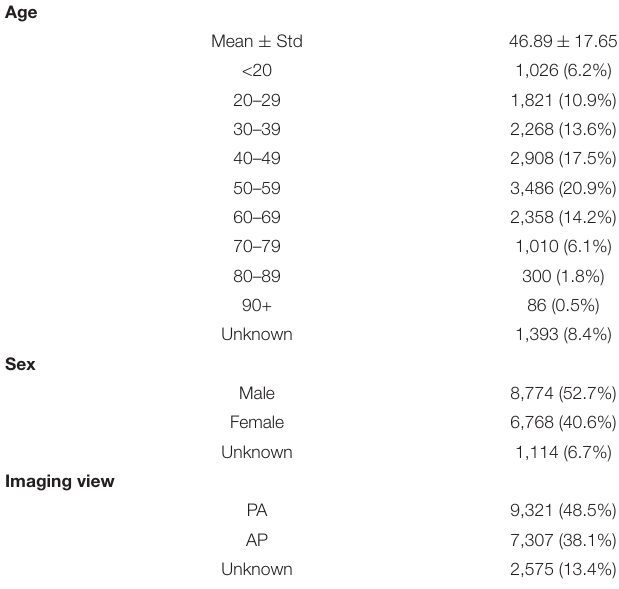
TABLE 1 | Summary of demographic variables and imaging protocol variables of CXR data in the benchmark dataset. Age and sex statistics are expressed on a patient level, while imaging view statistics are expressed on an image